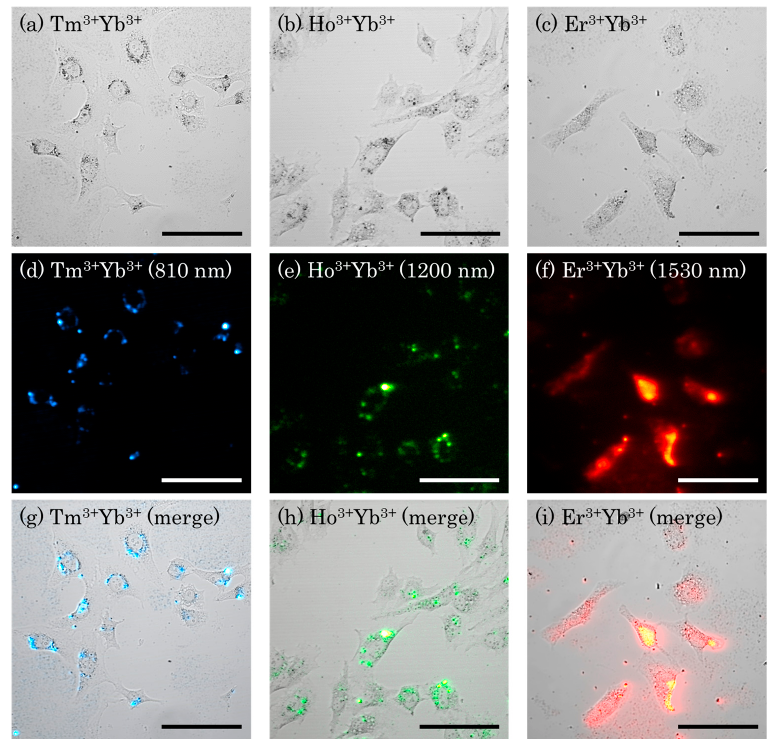
Figure 5. ( a – c ) are bright field images of HeLa cell uptake with Gd 2 O 3 : Tm 0.1 mol %/Yb 2 mol % ( a ); Gd 2 O 3 : Ho 1 mol %/Yb 2 mol % ( b ); and Gd 2 O 3 : Er 1 mol %/Yb 2 mol % ( c ); ( d – i ) show the emission